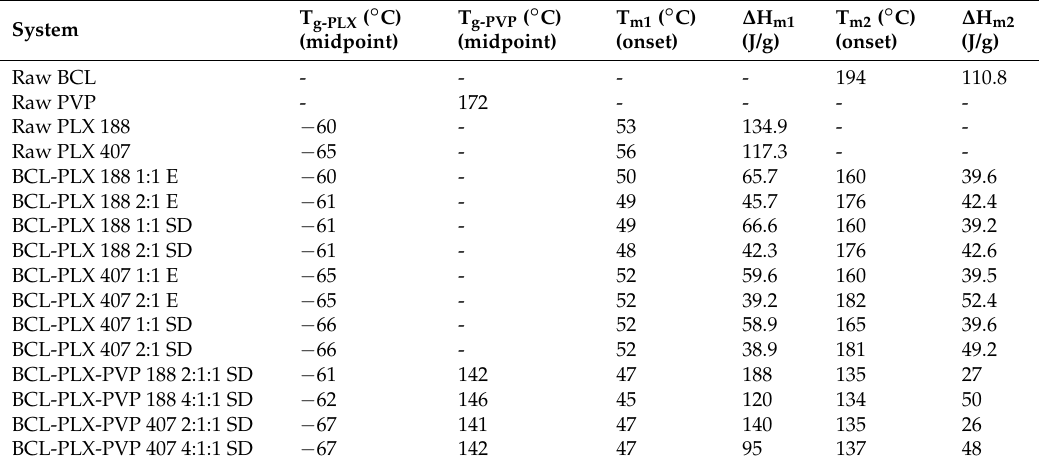
Table 2. Comparison of the T g , T m1 , and T m2 values of raw BCL, poloxamers, PVP, binary systems containing bicalutamide and either PLX188 or PLX407 (obtained using evaporation method (E) and spray drying (SD)), and ternary systems containing bicalutamide, PLX, and